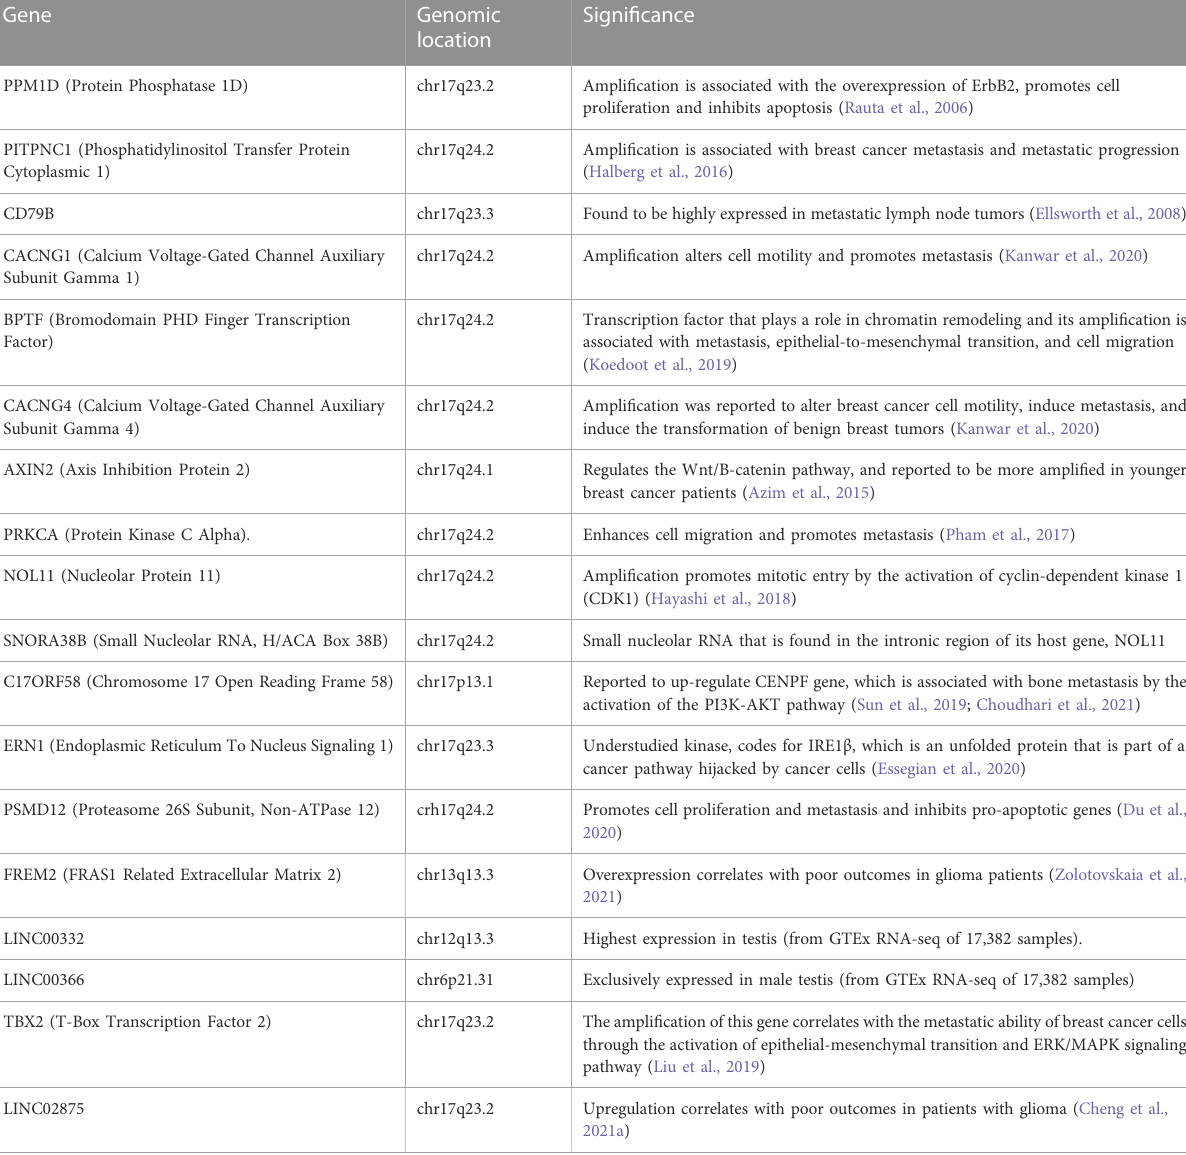
TABLE 2 Signi fi cantly ampli fi ed genes in women with early onset breast cancer and their clinical signi fi cance.